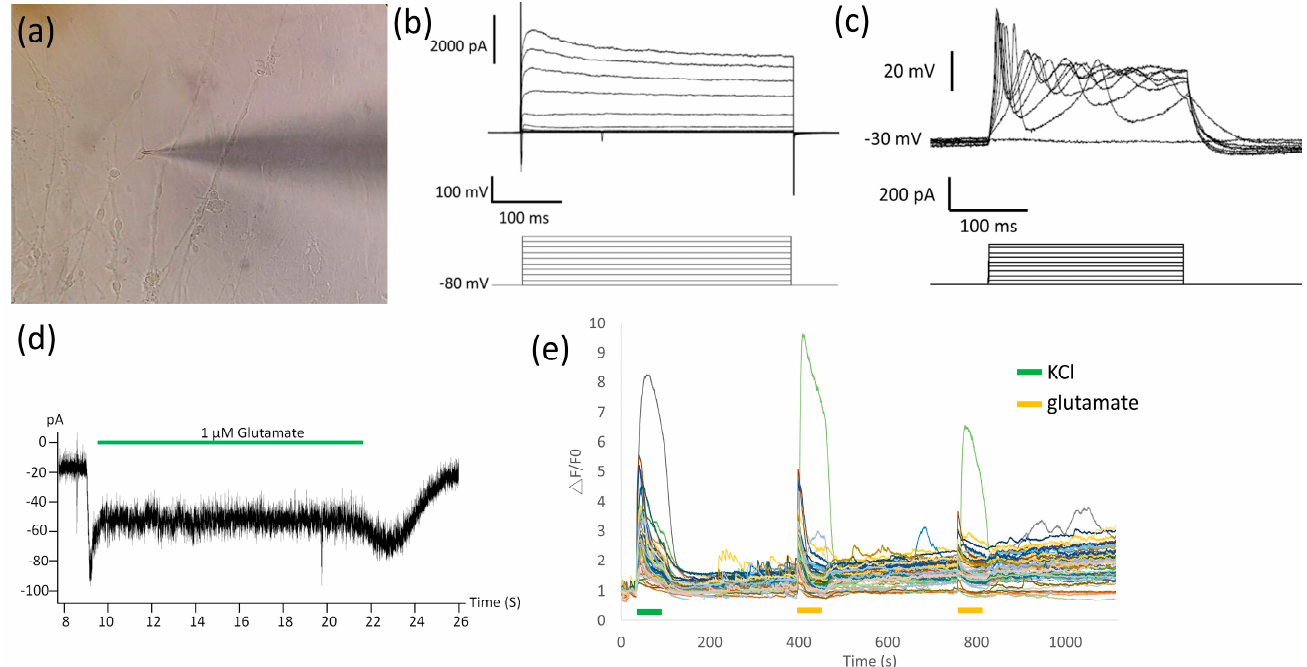
Figure 4. Classical functional electrophysiological properties of thawing MNs. ( a ) Image of patch- clamp cells and electrodes. ( b ) Voltage-gated ion current elicited via voltage stimulation. ( c ) Firing characteristics of MNs in response to 200 pA current injections. ( d ) Spontaneous and receptor- mediated postsynaptic currents via the glutamate treatment of MN. ( e ) Calcium flux changes of MNs via potassium chloride and glutamate stimulation.